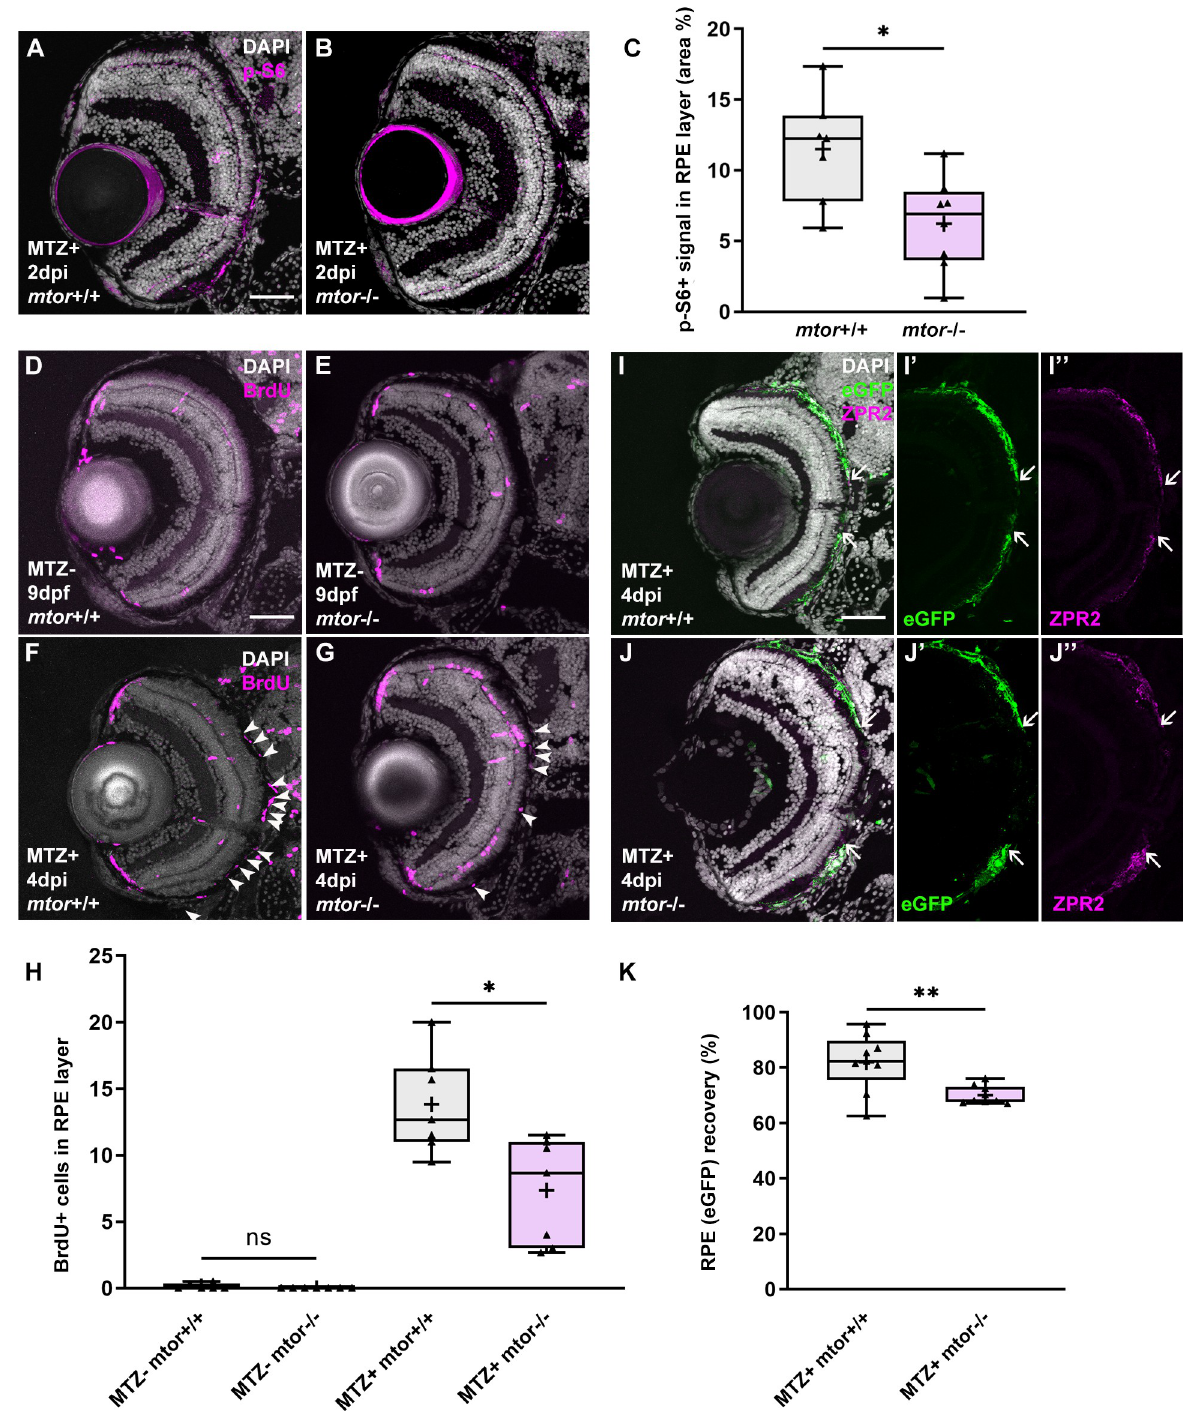
Fig 3. Mutation in mtor impairs RPE regeneration. (A,B) Immunofluorescent images of p-S6 staining on transverse cryosections from ablated mtor +/+ and mtor -/- at 2dpi. Nuclei (white), p-S6 (magenta). (C) Quantification of the p-S6 signal in the RPE layer revealed a significant decrease in MTZ + mtor -/- larvae, when compared to MTZ + mtor +/+ siblings. (D,E) Immunofluorescent images of BrdU staining on transverse cryosections from MTZ- (D,E) and MTZ + (F,G) mtor +/+ and mtor -/- larvae at 9dpf/4dpi Nuclei (white), BrdU (magenta). (H) Quantification of BrdU + cells in the RPE layer showed no significant differences between MTZ - mtor +/+ and mtor -/- larvae, but a significant decrease in MTZ + mtor -/- larvae when compared to MTZ + mtor +/+ siblings. (I-J) Immunofluorescent images of ZPR2 staining on transverse cryosections from MTZ + mtor +/+ and mtor -/- larvae at 4dpi. Single channel (I’ J’) rpe65a :nfsB-eGFP images and (I” J”) ZPR2 images. Nuclei (white), eGFP (green), ZPR2 (magenta). White